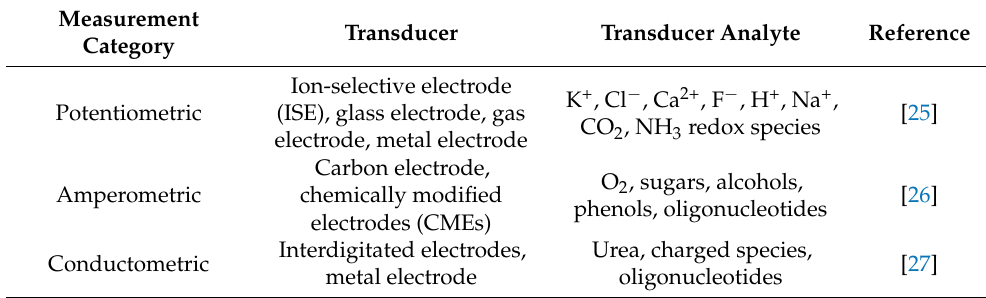
Table 2. Types of electrochemical transducers for various kinds of sensors along with the analytes they